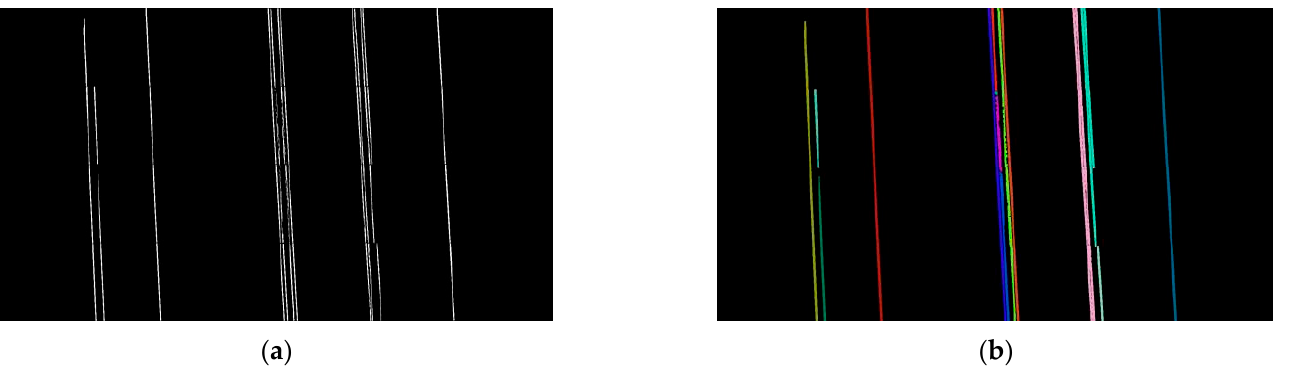
Figure 7. Attach different labels to each connected domain. ( a ) Before adding tags; ( b ) after adding tags.